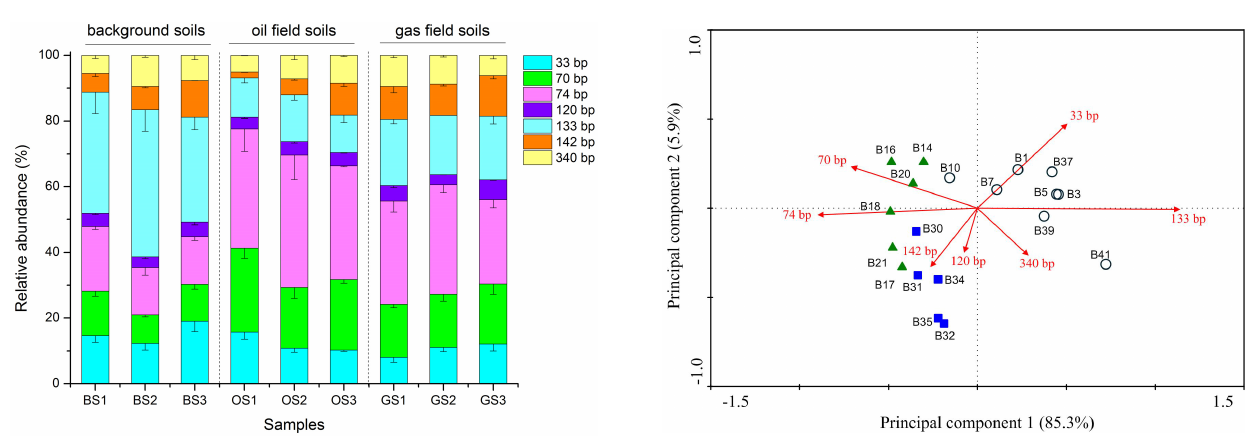
Fig. 4. PCA ordination plot for the samples and T-RFs based on alkB T-RFLP data from different soil samples. Symbols: red arrows = T-RFs (the size in base pairs of forward T-RFs by Msp I); green triangles, blue squares, black circles and associated numbers indicate oil field surface soils, gas field surface soils, background soils and sample serial numbers, respectively.